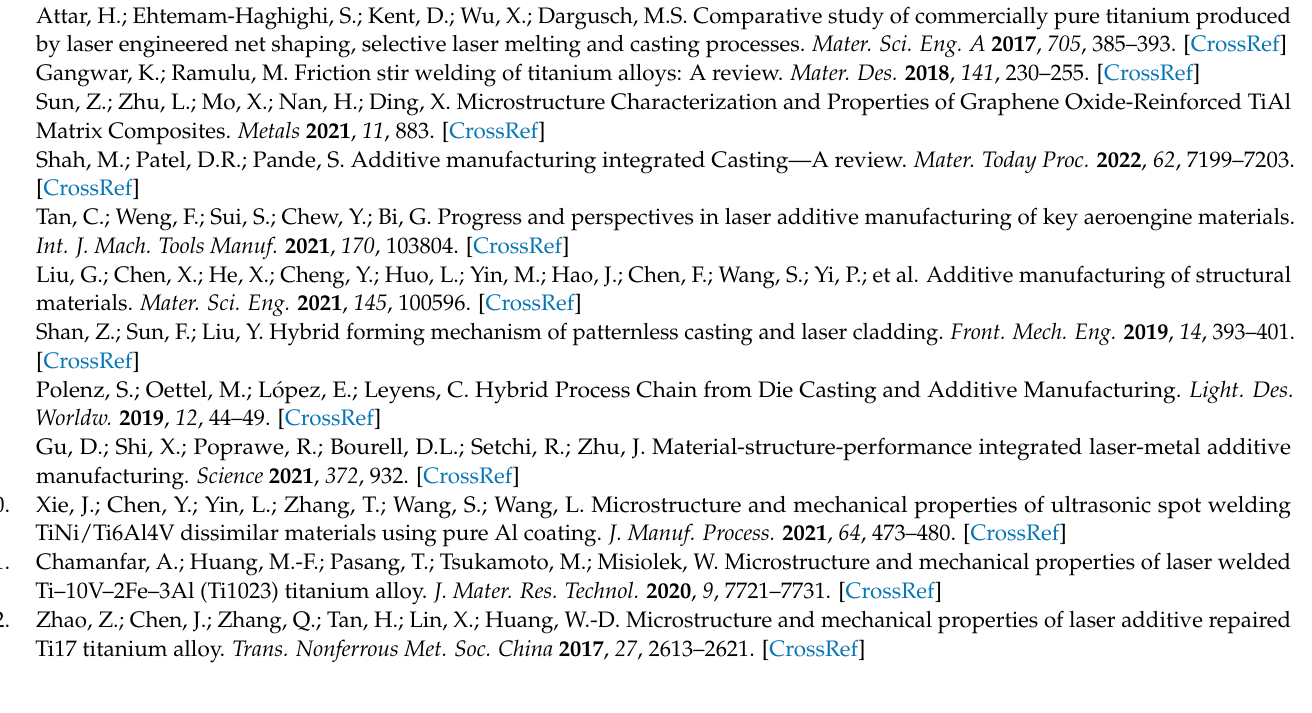
Grains in the bottom of the LAM zone exhibit a mixture of equiaxed grain and small columnar grain and gradually coarsen to fully large columnar morphology growing consecutively through many layers in the middle and upper region. The width of the large columnar grain is stable at about (150~400) µ m. While grains in the HAZ are elongated and exhibit columnar morphology. The average width and length of the elongated grain reach about 4.8 mm and 9.2 mm, respectively. (3) Ultra-fine basket-wave microstructure forms within the large columnar grain of the LAM zone, and extremely fine basket-wave microstructure forms just above the fusion line in the bonding zone. As the distance from the fusion line increases, the microstructure in the TZ transforms from a fine basket-wave microstructure to a bimodal microstructure. (4) Microhardness of the hybrid sample in the extremely fine basket-wave microstructure region of the bonding zone is the highest. It reaches 491 HV. Fracture of all the hybrid samples occurs in the HAZ of the casting half in tensile testing, and the tensile strength of the hybrid sample reaches (821 ± 31) MPa, which is higher than that of the pure casting sample. While the elongation of the hybrid sample is lower than that of the pure casting